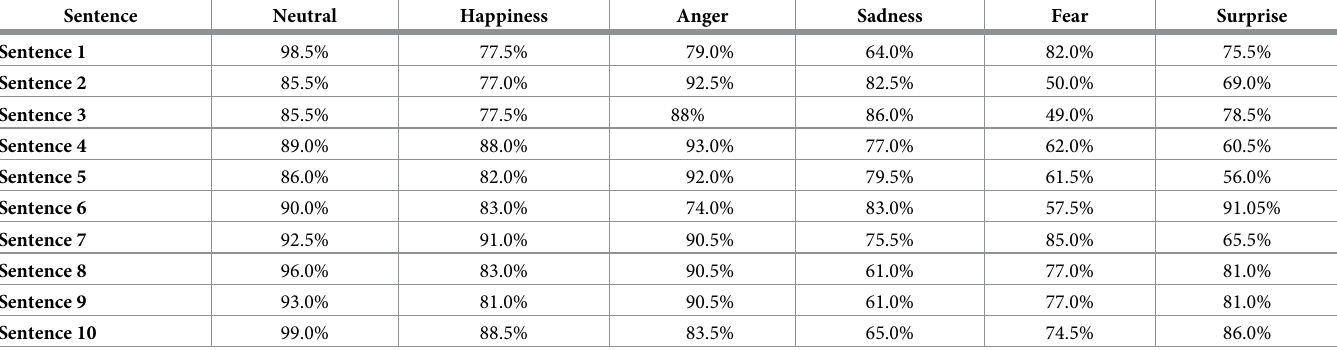
Table 10. Sentence-wise recognition rates for Phase